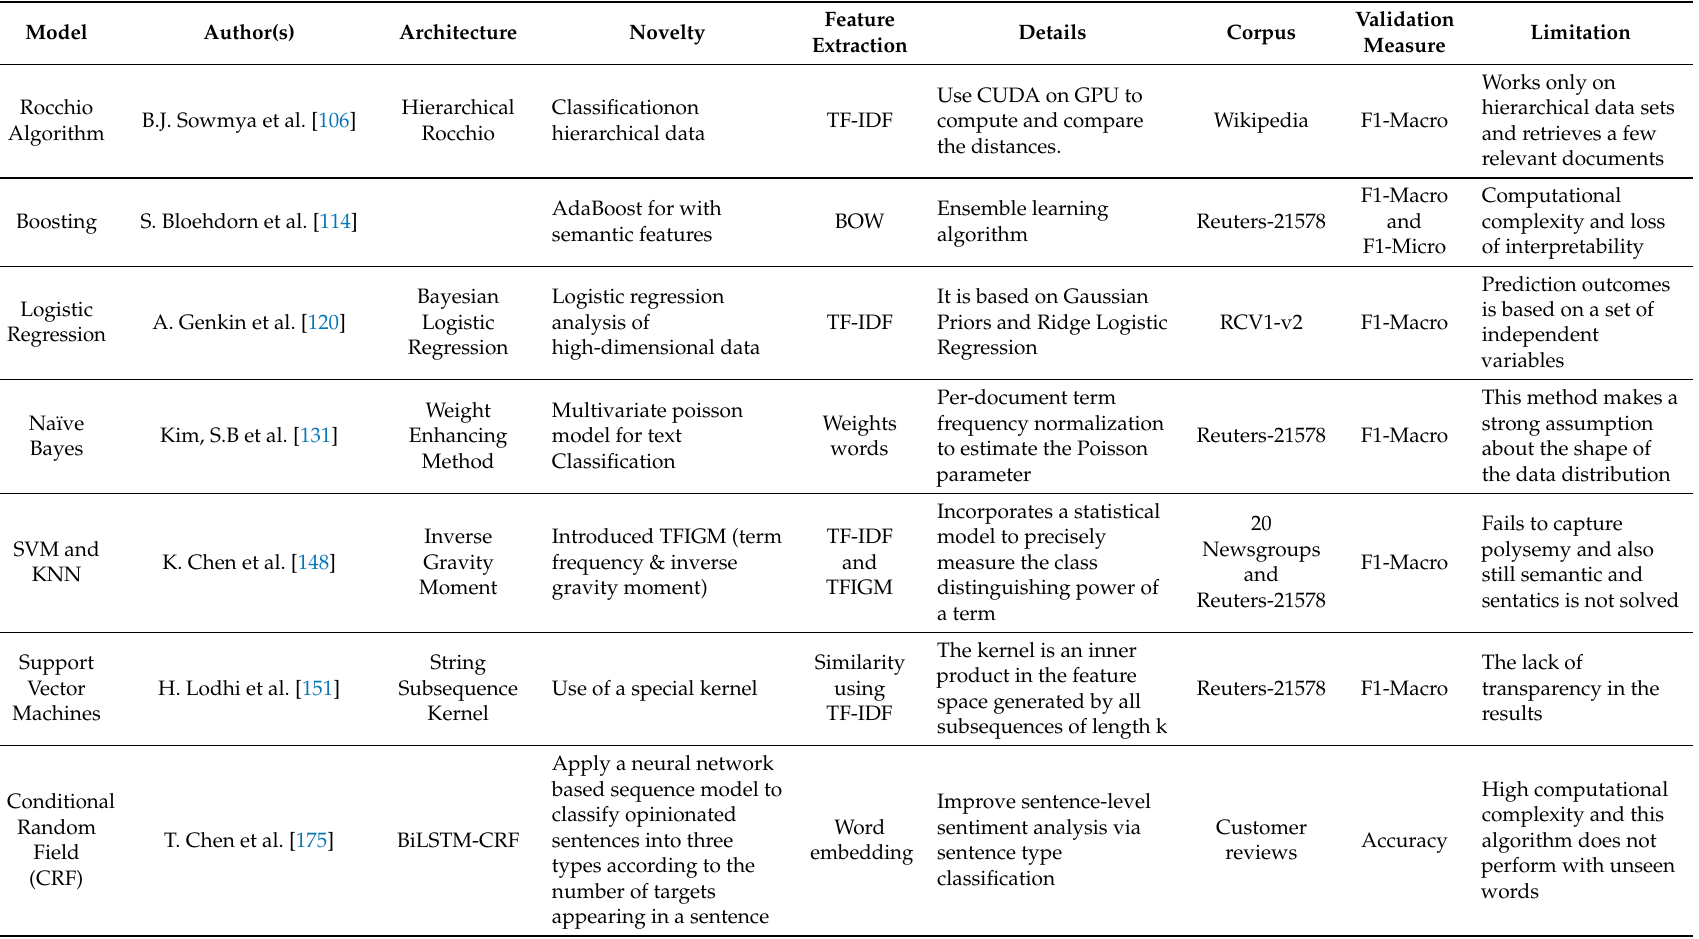
Table 4. Comparison of text classification